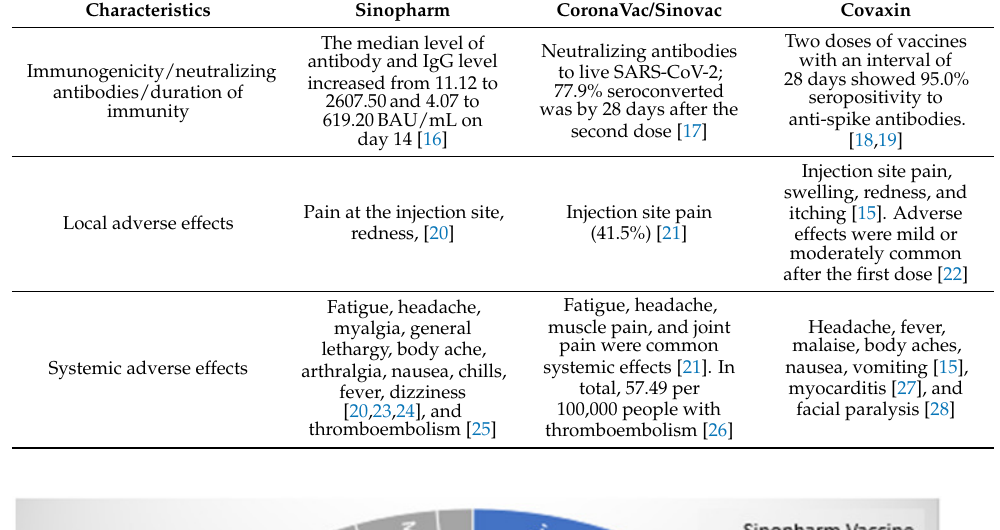
Table 2. Comparison of immunogenicity and adverse effects between the Sinopharm, CoronaVac, and Covaxin vaccines against COVID-19 infection.